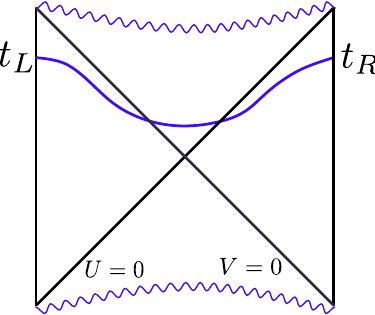
Fig. 16 Penrose diagram of the two-sided black hole in AdS and the maximal-volume surface connecting two constant time slices on the opposite boundaries